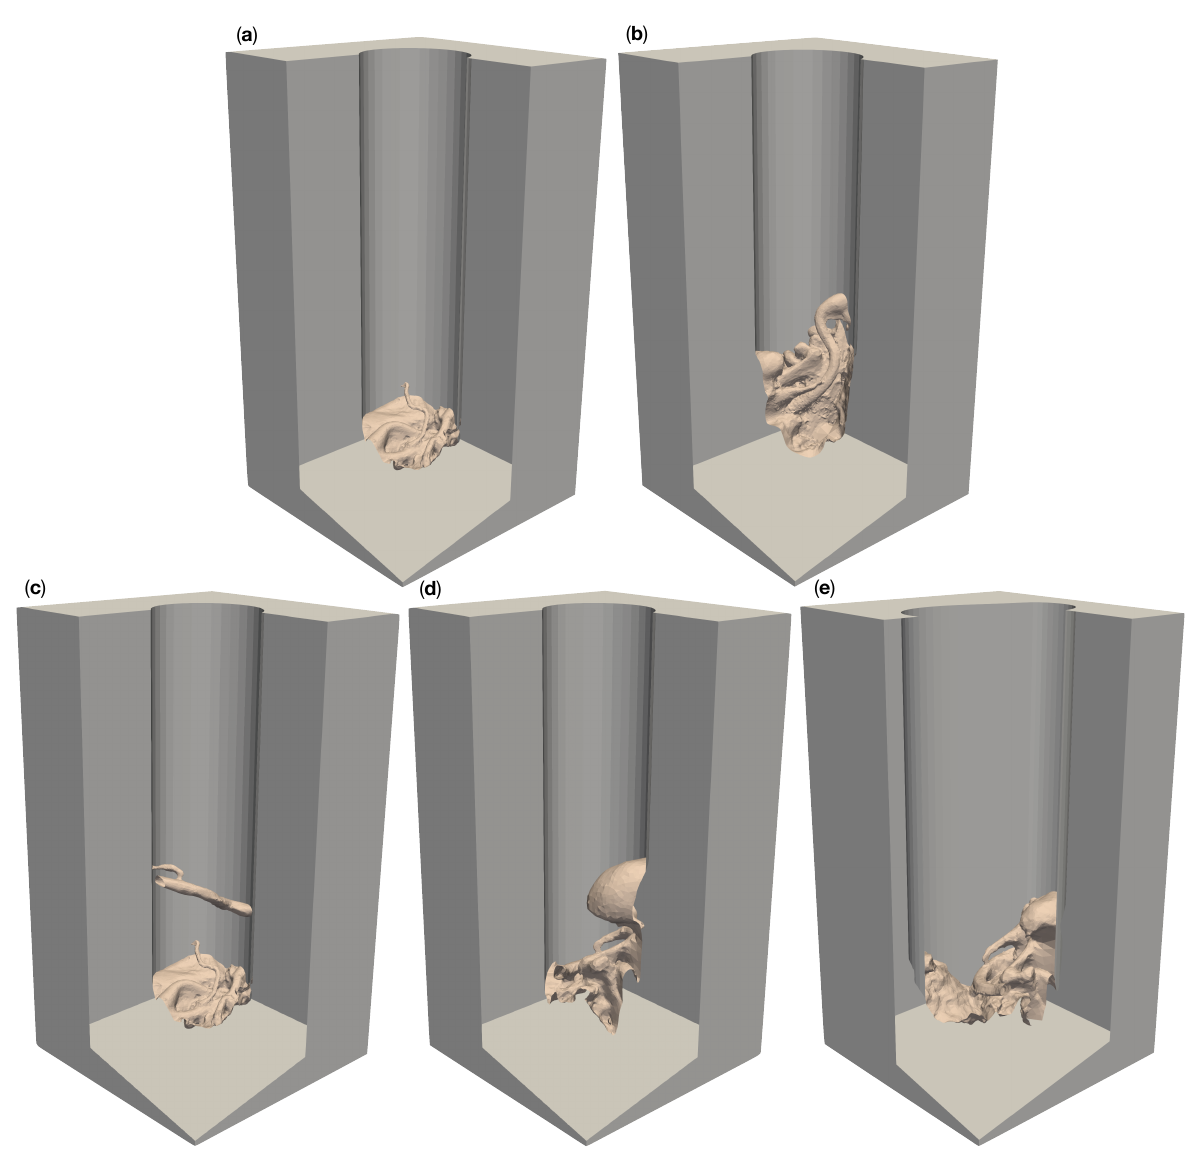
Figure 3. Five different artificial patient surgical site models with 100mm deep operative corridors. “Circ flat anatomy”, shown in ( a ), contains a rather flat topology. “Circ angled anatomy” in ( b ) features a network of arteries, tissue furrows and undercuts, which are set at an angle in the corridor. “Circ artery” ( c ) has the same flat topology as in ( a ) at the bottom of the operative corridor but adds an artery spanning the operative corridor. ( d ) shows a topology consisting of a mixture of arteries, tissue furrows, undercuts, dominated by a large overhang protruding from the channel wall. This model is called “circ overhang”. The model in ( e ) combines features from ( b , d ), set in an operating corridor with a deformed elliptical cross-section, hence its name: “elliptical